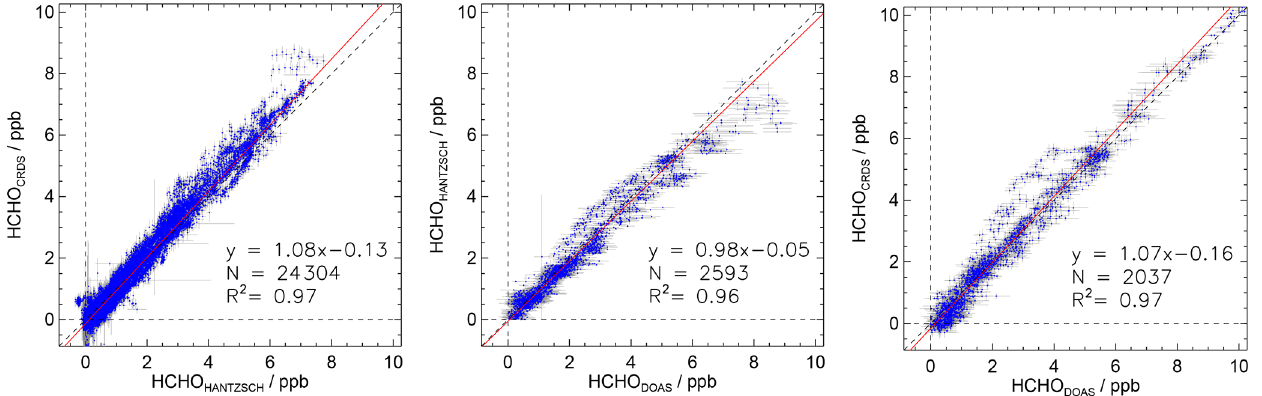
Figure 8. Correlation plots of measurements obtained by the Hantzsch, CRDS and DOAS instruments during experiments performed in the SAPHIR chamber. Data were acquired between June to December 2019 (time resolution: 180s). Red lines show results from regression analysis. Error bars represent 1 σ errors in the